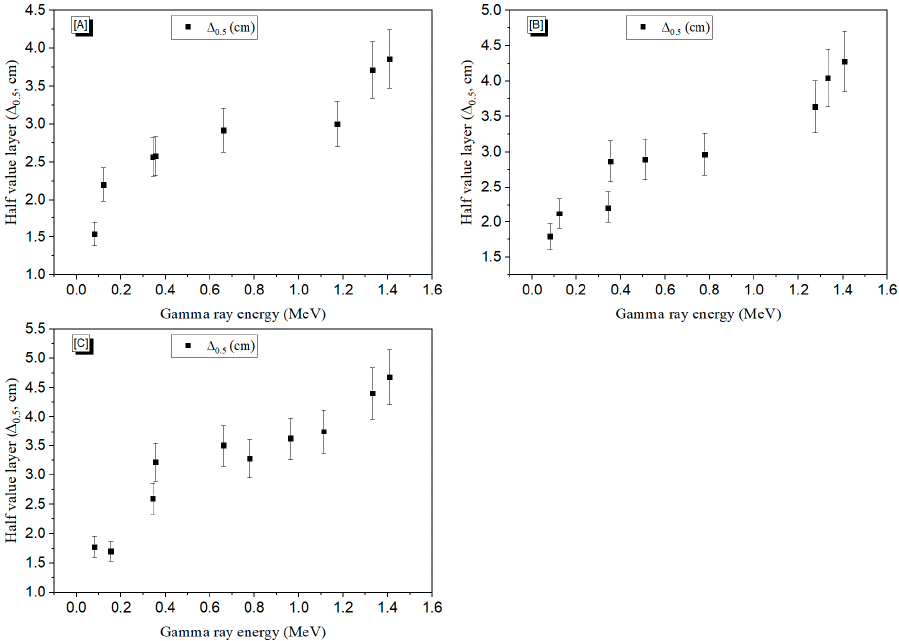
Figure 7. The TF and RPE values as a function of the incoming γ -ray energy (E γ ) for the three fabricated concrete series ( A ), ( B ), and ( C ) with W/C ratios 0.4, 0.6, and 0.8.